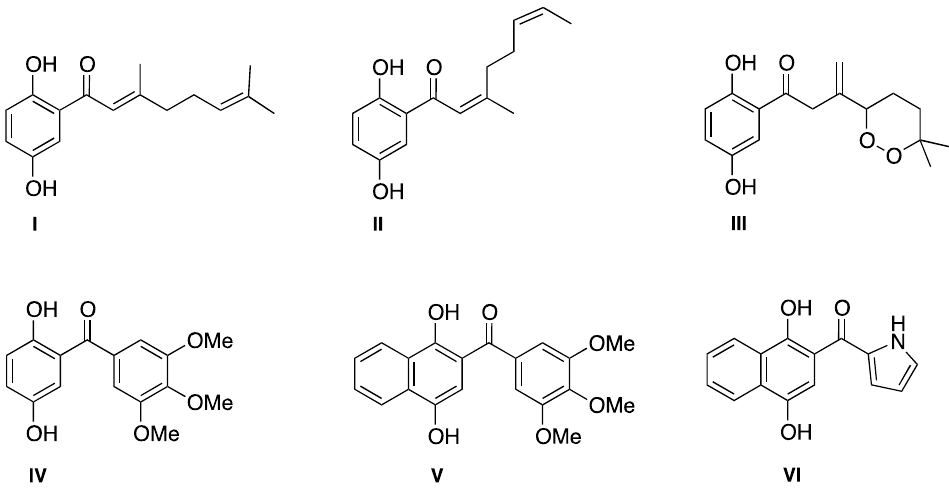
Figure 1. Structure of natural ( I – III) and synthetic ( IV – VI) bioactive